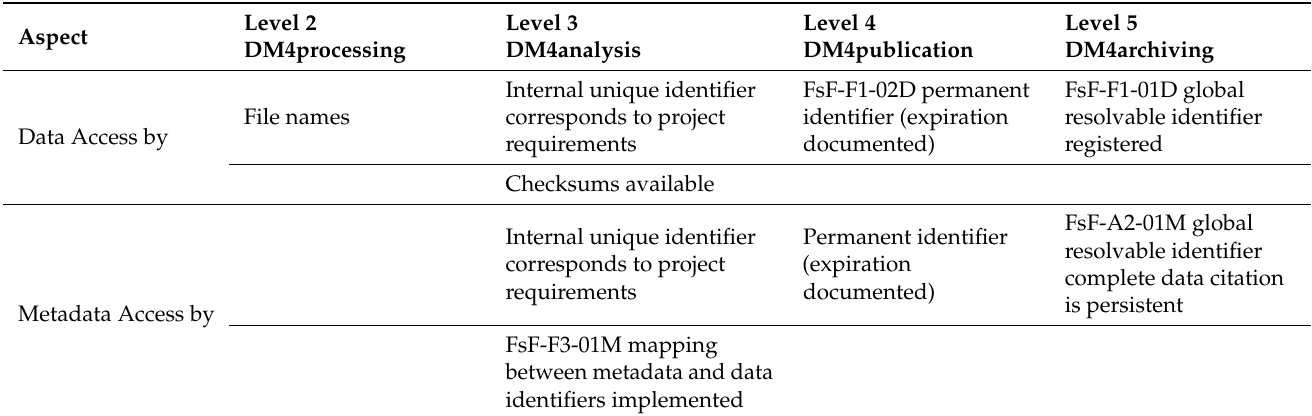
Table A2. Maturity matrix, criterion accessibility. Removed measures from [34] are not listed in the table.